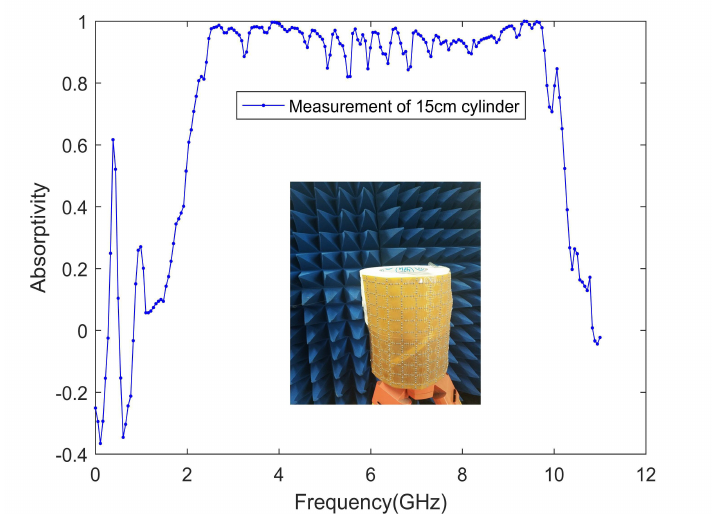
Figure 11. Measurement of the absorption rate attached to the